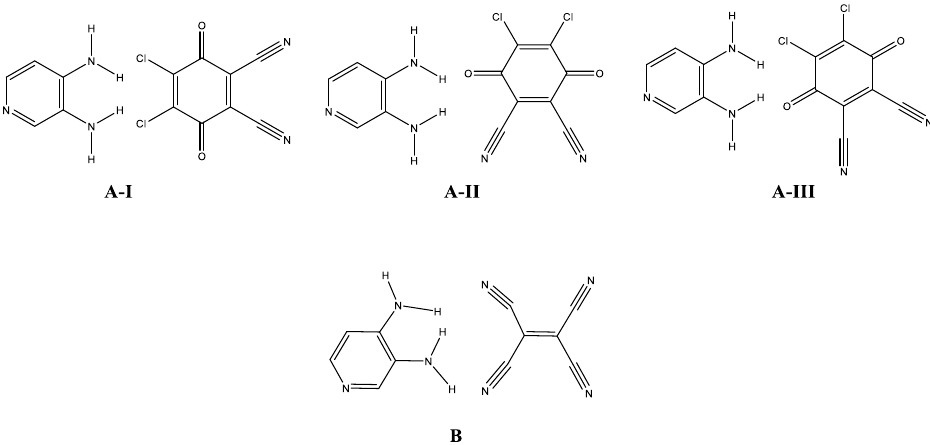
Figure 11. Proposed molecular structures of ( A ) AMFP – DDQ and ( B ) AMFP – TCNE CT complexes.